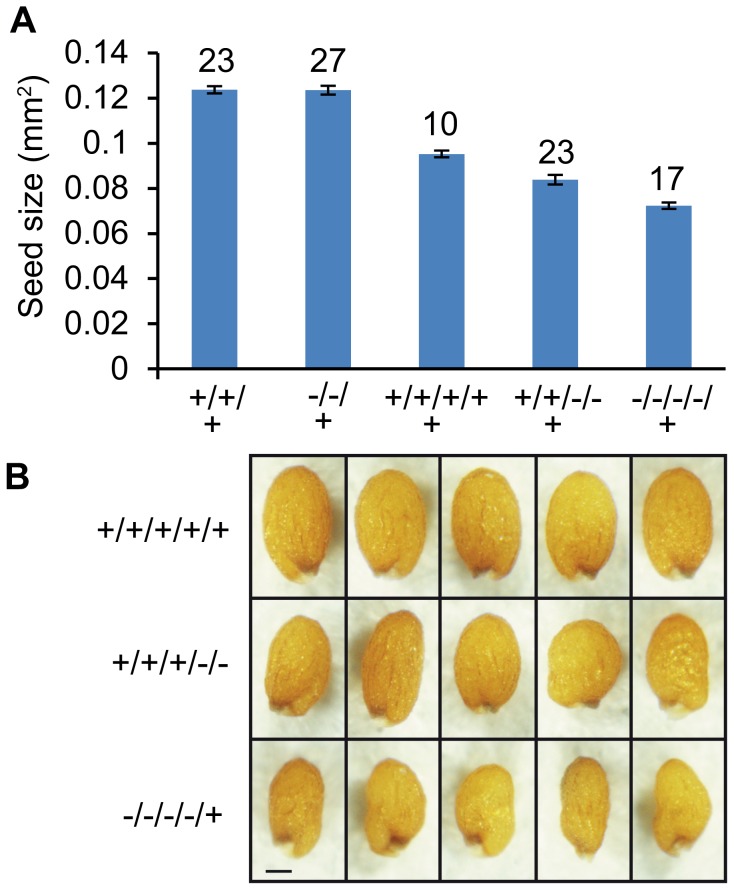
Size of Triploid Seeds Is Dependent on the Dosage of AGL62.(A) Size of seeds derived from crosses agl62/AGL62; osd1/osd1×wild type and diploid seeds from crosses agl62/AGL62×wild type. Average seed size of different genotypes is shown. Wild-type (+) and mutant (−) allele frequencies of AGL62 in the endosperm are shown below the x axis. Numbers on top of bars refer to numbers of analyzed seeds. Error bars indicate s.e.m. (B) Images of triploid seeds from the three categories shown in (A). Bar = 0.1 mm.